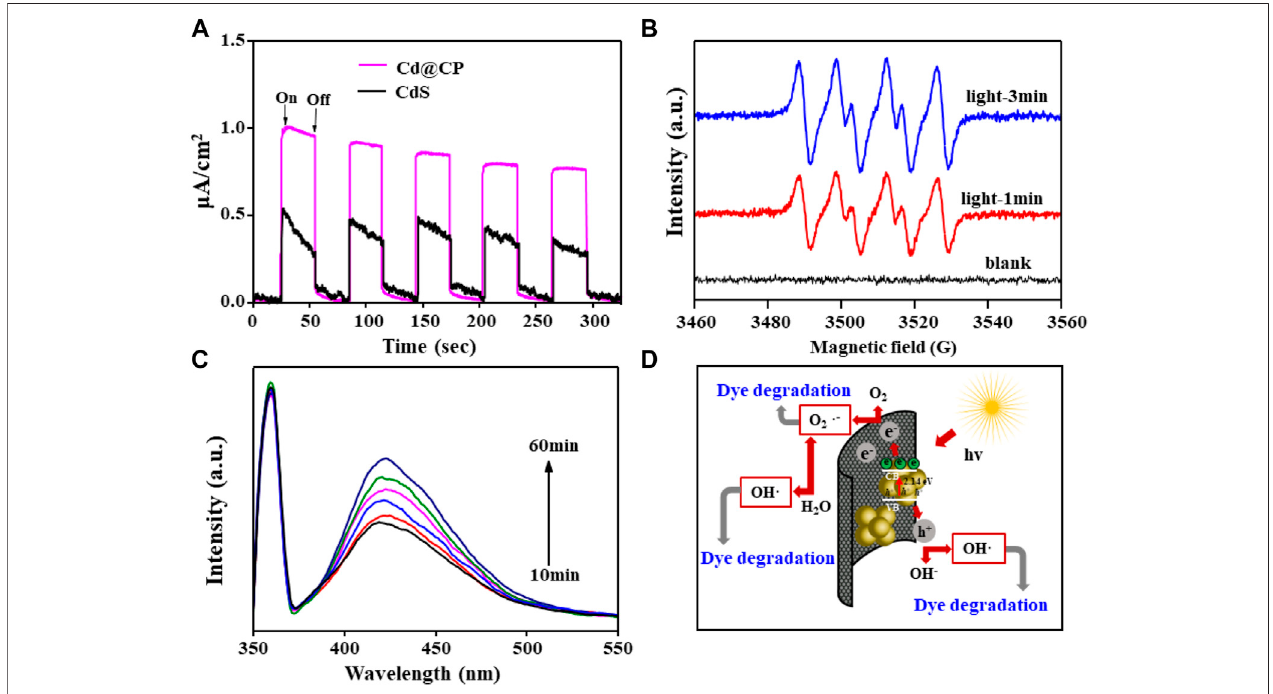
FIGURE 5 | (A) Transient photocurrent plots for single-CdS and CdS@CP; (B) EPR spectrum of superoxide by DMPO for CdS@CP; (C) fl uorescence spectra of hydroxyl radicals trapped by TAOH for CdS@CP; (D) photocatalytic degradation mechanism of CdS@CP.